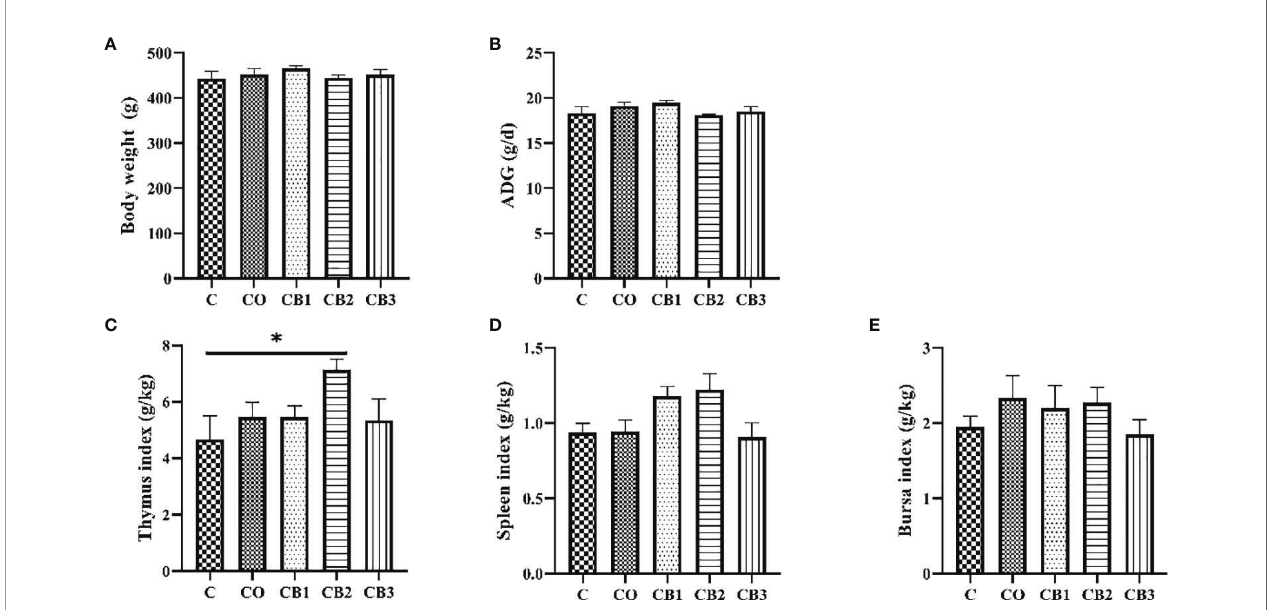
FIGURE 1 | Effects of dietary chitosan oligosaccharides (COS) and Clostridium butyricum synbiotic supplementation on growth performance and immune organ index in early-weaned pigeon squabs. (A) Body weight of squabs at 25 days of age. (B) ADG, average daily gain. (C) Thymus index. (D) Spleen index. (E) Bursa index. Values are means with the SEM of eight squabs. * p < 0.05. C group, control group, squabs fed with arti fi cial crop milk; CO group, squabs fed with arti fi cial crop milk + 150 mg/kg COS; CB1, CB2, and CB3 group, squabs fed with arti fi cial crop milk + 150 mg/kg COS + 200, 300, and 400 mg/kg C. butyricum ,